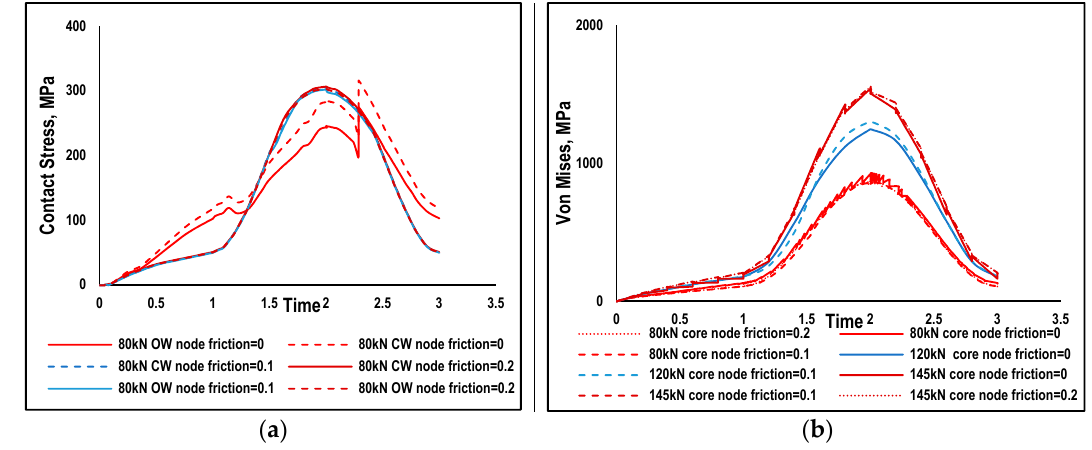
Figure 8. ( a ) Contact Stress at Neighboring nodes ( b ) Von Mises Stress at Neighboring nodes under different axial loads.